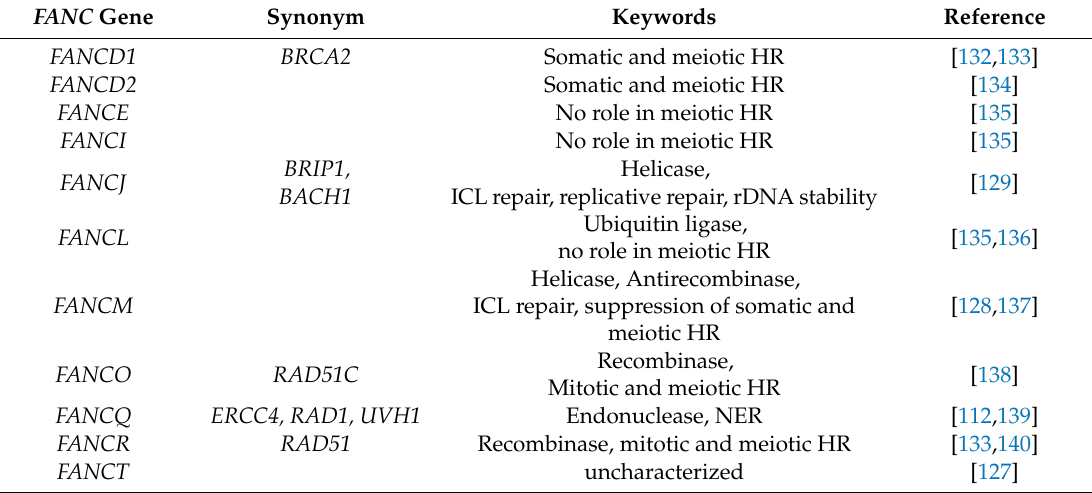
Table 1. FANC genes in plants. The table gives an overview of the conserved FANC genes in plants, the synonymous nomenclature where present, keywords and their functions and respective